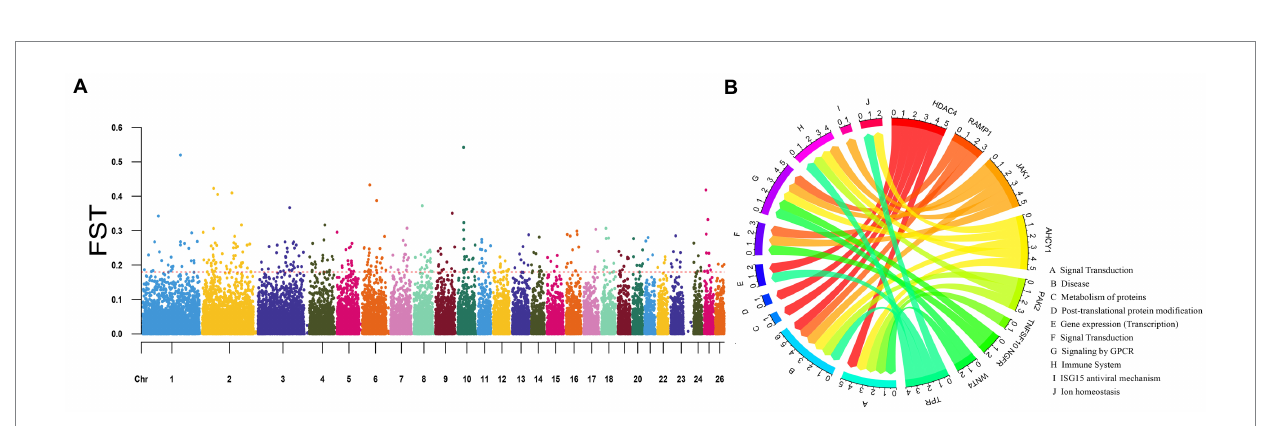
FIGURE 4 Fst detection results of four sheep breeds. (A) The red line represents the 5% threshold line. (B) Enrichment results of candidate gene